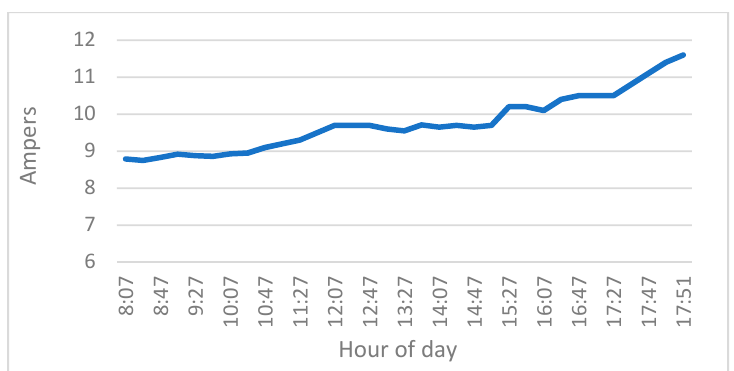
Figure 38. BB current in discharge mode.